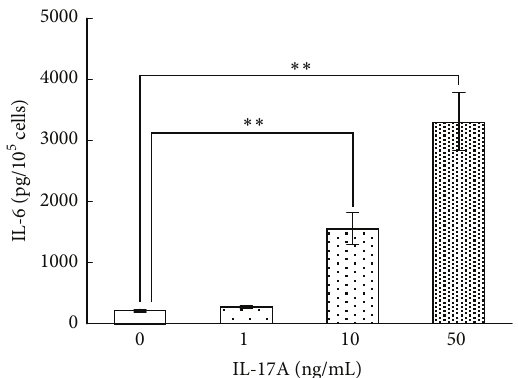
Figure 5: Effects of IL-17A on IL-6 protein production by synovial fibroblasts. Synovial fibroblasts were treated with the indicated concentrations of IL-17A for 24h. The IL-6 protein levels in the conditioned medium were then assayed using ELISA. Data are shown as means ± SD ( 𝑛 = 6 ); ∗∗ 𝑃 < 0.01 .